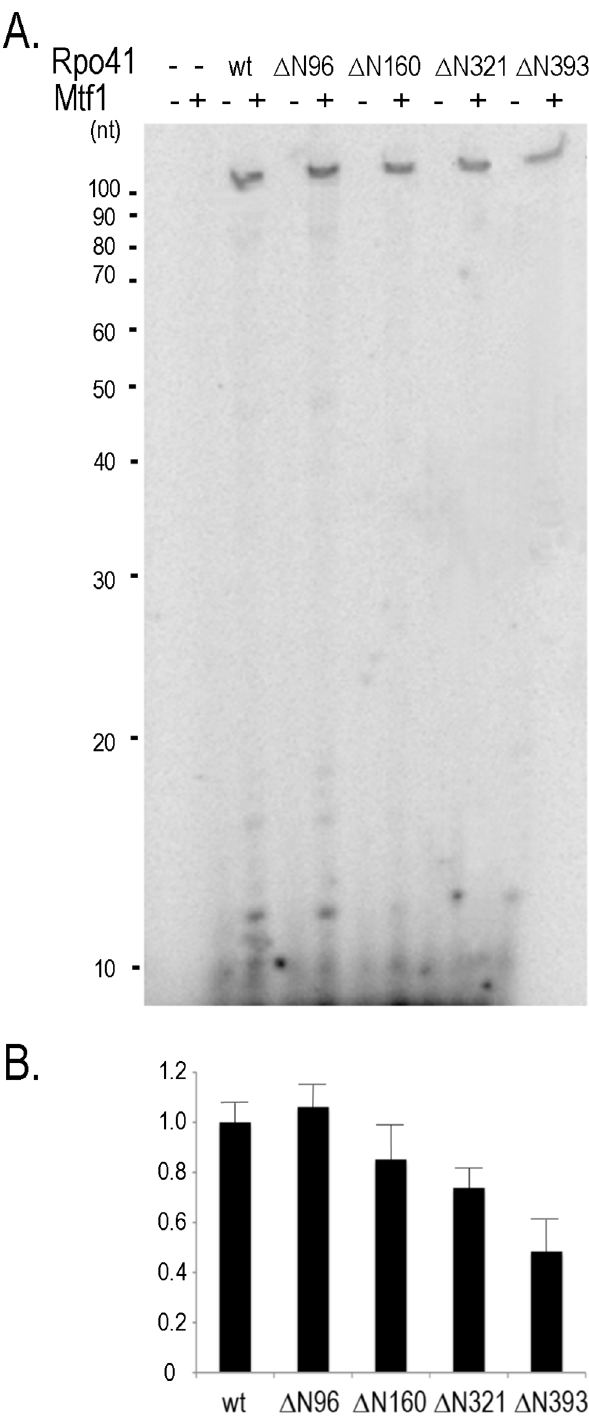
Fig 3. Activities of Rpo41 variants on a supercoiled DNA containing a 14S rRNA promoter. (A). Transcription was carried out in the presence of ATP, UTP, GTP and [ γ - 32 P]ATP (no CTP) with 0.5 μ M Rpo41 (wild-type or a variant) in the absence or presence of 0.5 μ M Mtf1 using 0.2 μ M pJJ1305 as template. (B). The 107-mer RNA products quantified using software. Quantity One.